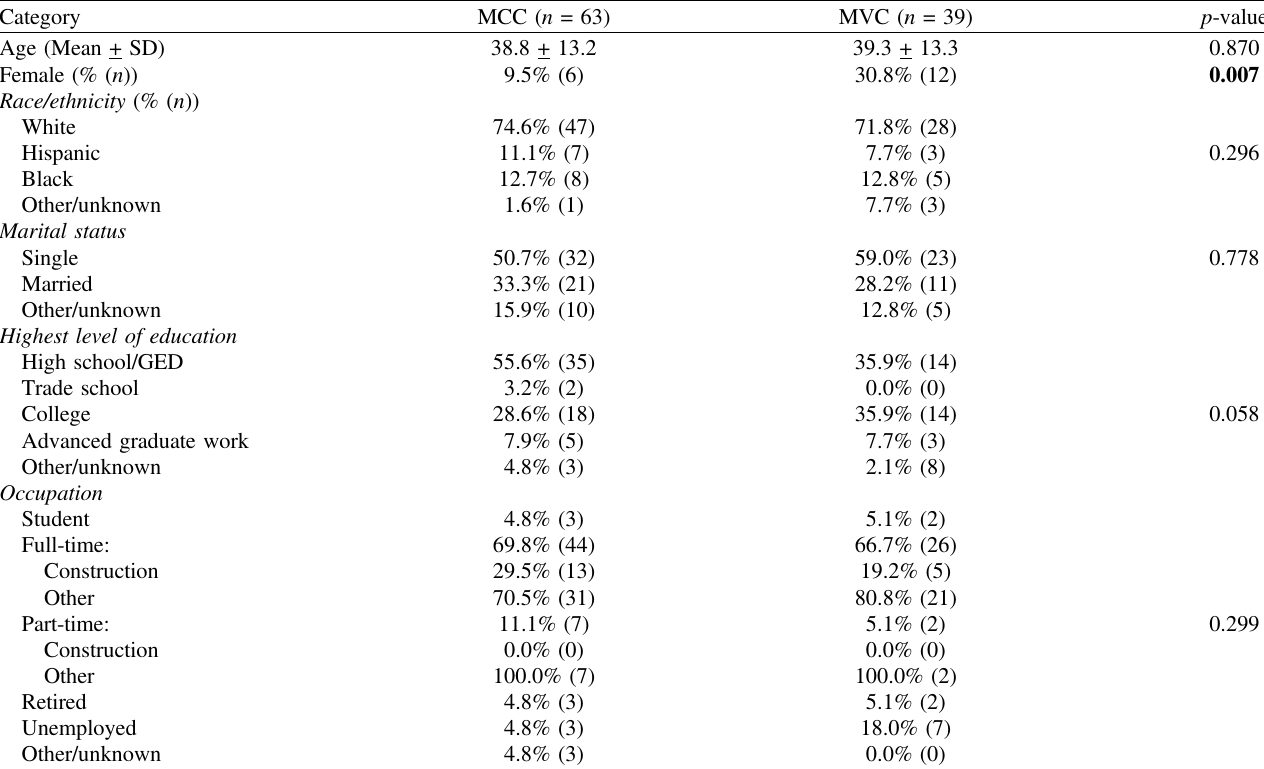
Table 2. Patient demographic